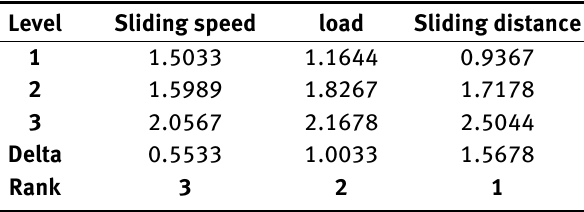
Table 8: Response table for means for mono composite (Al2219+8%